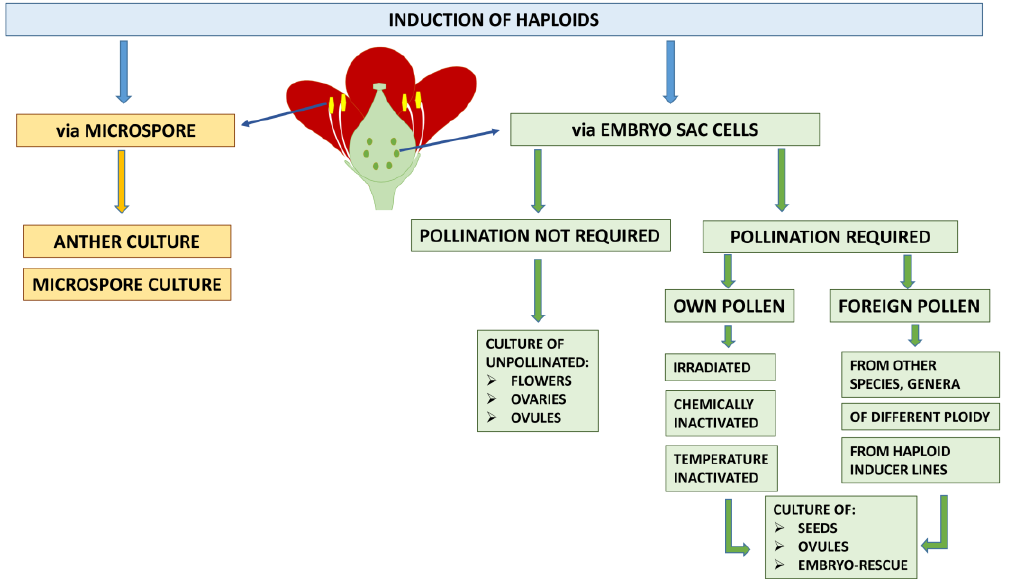
Figure 1. Methods and techniques of haploid plant production in vitro via male (yellow path) and female (green path) gametophytes.